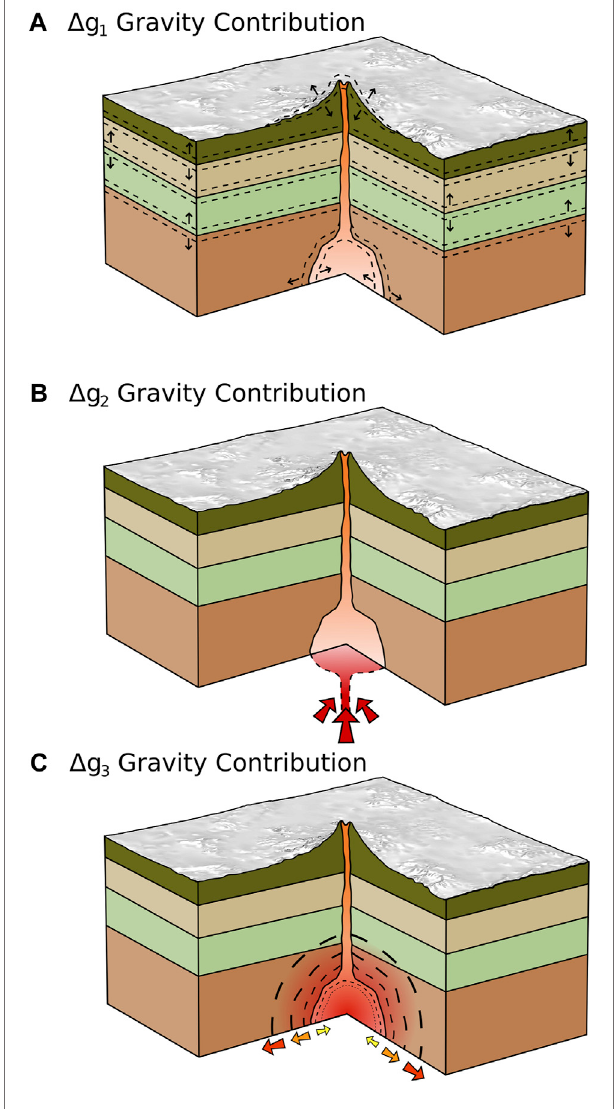
FIGURE 2| Schematics ofthe principalcontributions to gravity changes measured at volcanoes from changes in the subsurface density distribution produced by: (A) the displacement of density boundaries (including the free surface,thesourcewalls,andcrustaldensityboundaries), (B) thesource mass change, and (C) the volume change of the reservoir itself modulated by crustal compressibility (after Bonafede and Mazzanti (1998) and Currenti et al.